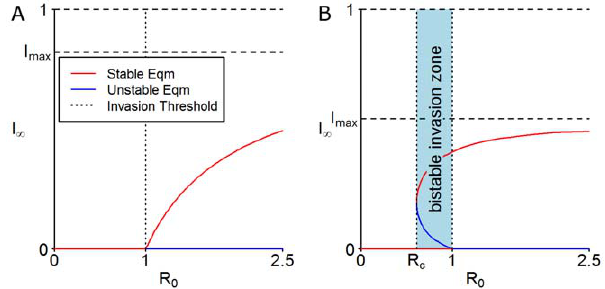
Figure 3. Critical fungicide properties required for bifurcation. A contour plot for critical fungicide properties (efficacy, application rate and decay rate) that defines the region where there is a bistable invasion zone. For values of p , d and e that lie within this region, the system exhibits a backwards bifurcation and a pathogen is able to invade and persist for values of R 0 v 1 . For parameter values outside this region the system exhibits a traditional bifurcation diagram and a pathogen is only able to invade for R 0 w 1 . Inset is a 3D perspective plot of the same surface. For these plots the growth rate of the host, l ~ 0 : 5 .